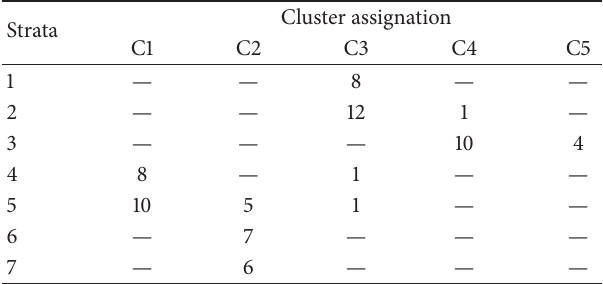
Table 4: Individual allocation to five genetic clusters according to strata determined by niche modelling of N. dombeyi in Chile. Clusters were identified by find.cluster function of adegenet R package using 124 adaptive single nucleotide polymorphisms (SNP).